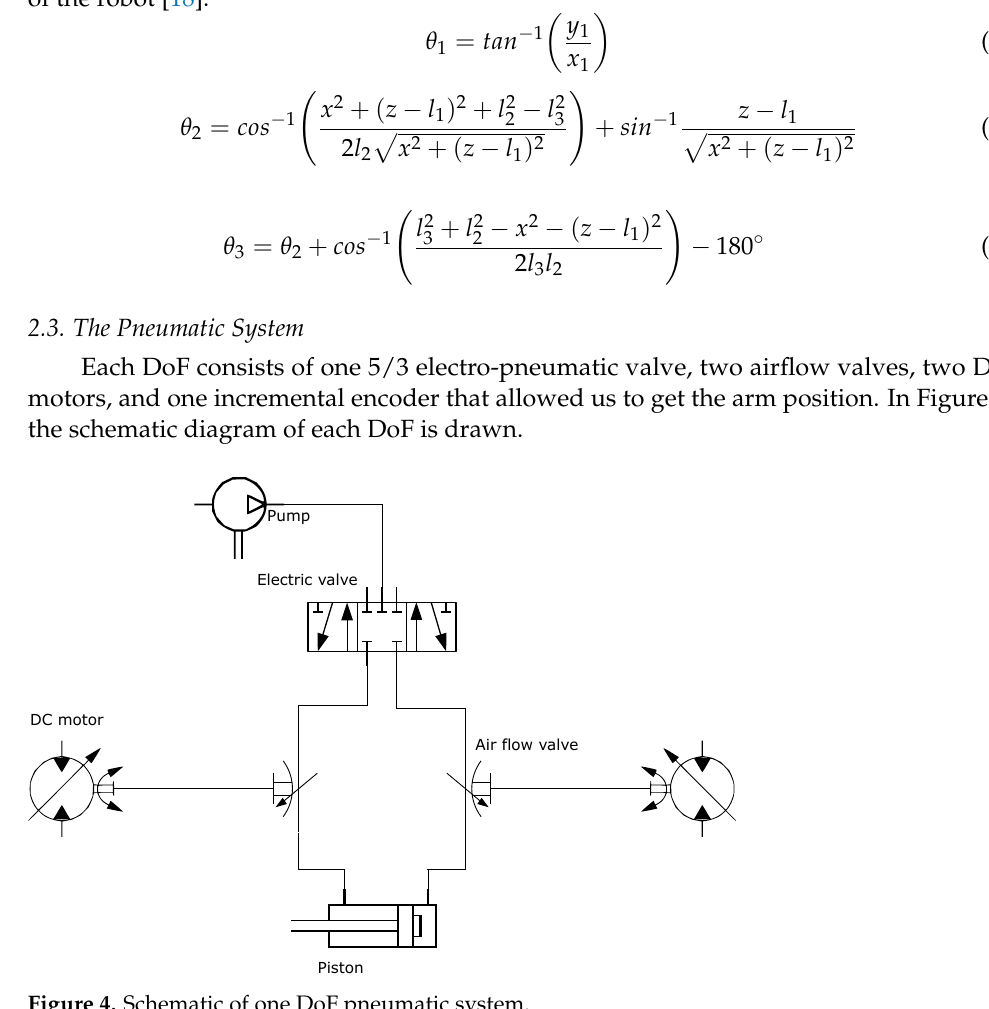
Figure 4. Schematic of one DoF pneumatic